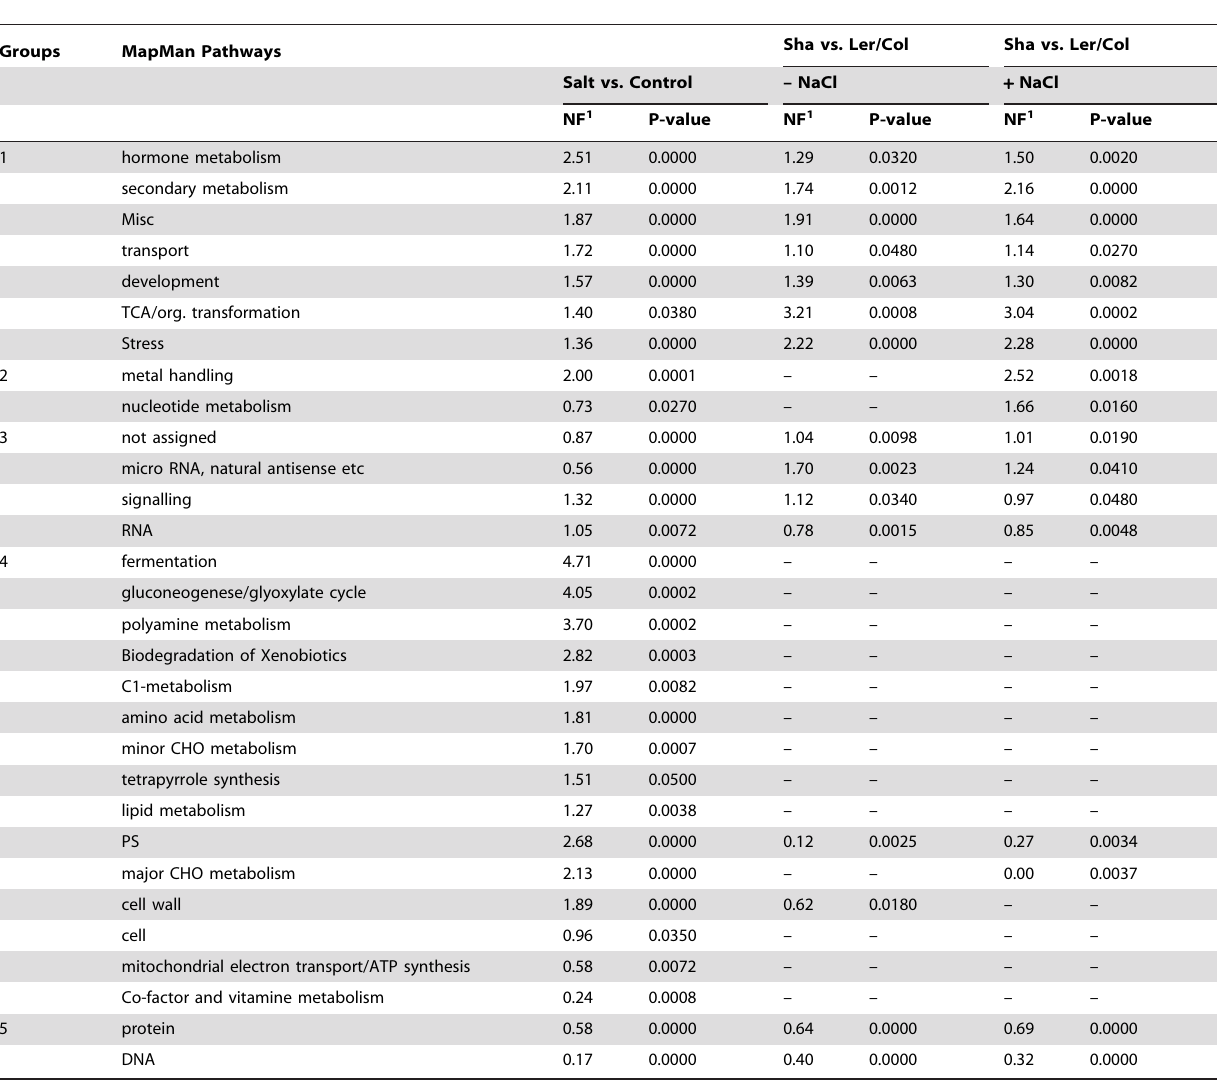
Table 1. Pathway enrichment analysis showed several pathways were enriched by salinity and ecotype effects.